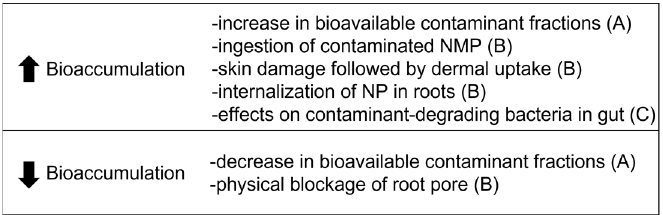
Figure 6. Overview of the mechanisms involved in the bioaccumulation of contaminants in the presence of nano- microplastics (NMP). Refer to the text for an explanation of the letters A, B, and C.